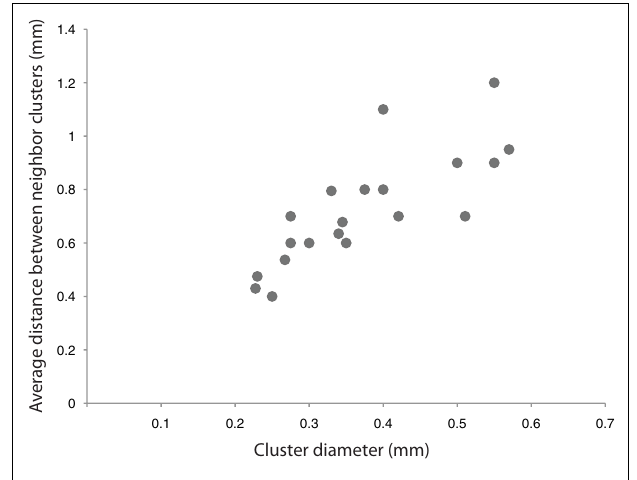
FIGURE 4 | The diameter of the distal bouton clusters, scales with the distance between the clusters (adapted from Binzegger et al., 2007) . Average measurement taken from various cortical areas and species (Rockland et al., 1982; Luhmann et al., 1986; Burkhalter and Bernardo, 1989; Kisvarday and Eysel, 1992; Yoshioka et al., 1992; Lund et al., 1993; Levitt et al., 1994; Fujita and Fujita, 1996; Kisvarday et al.,